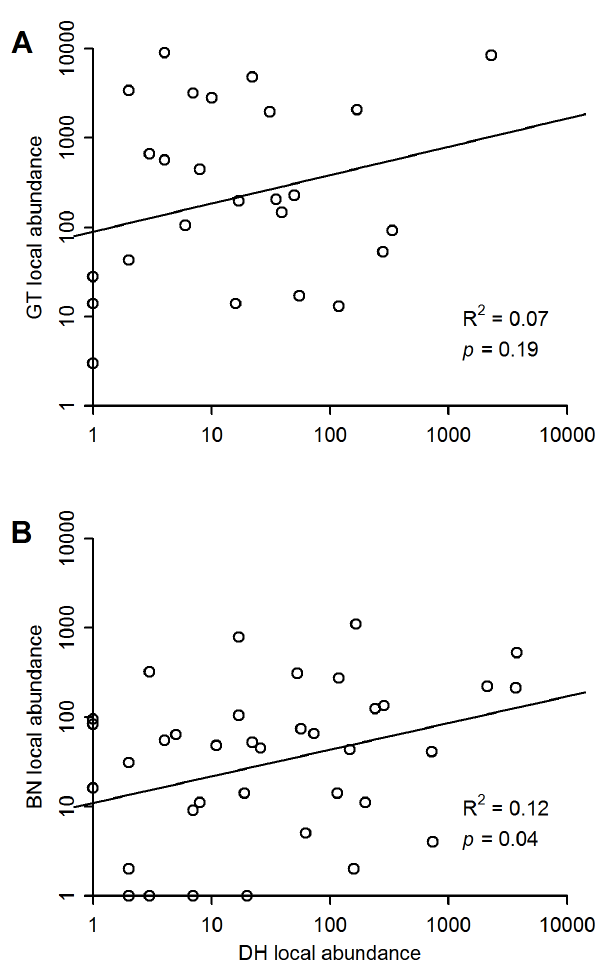
Figure 7. Correlation in local abundances of species between plots. Panel A is for Gutianshan (GT) vs. Dinghushan (DH). Panel B is for Xishuangbanna (BN) vs. Dinghushan. The axes are both log 2 - transformed. Lines are linear regressions and statistics from the Pearson correlation coefficients.